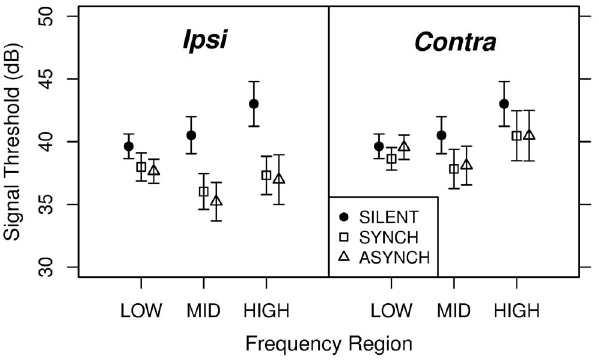
Figure 2. Average target thresholds in experiment 1 ( 6 1 s.e.). The left and the right panels show respectively the thresholds for detecting the target in the Ipsi and in the Contra conditions, for the SYNCH and ASYNCH precursor type. For the SILENT precursor type, the obtained thresholds are plotted in both panels.